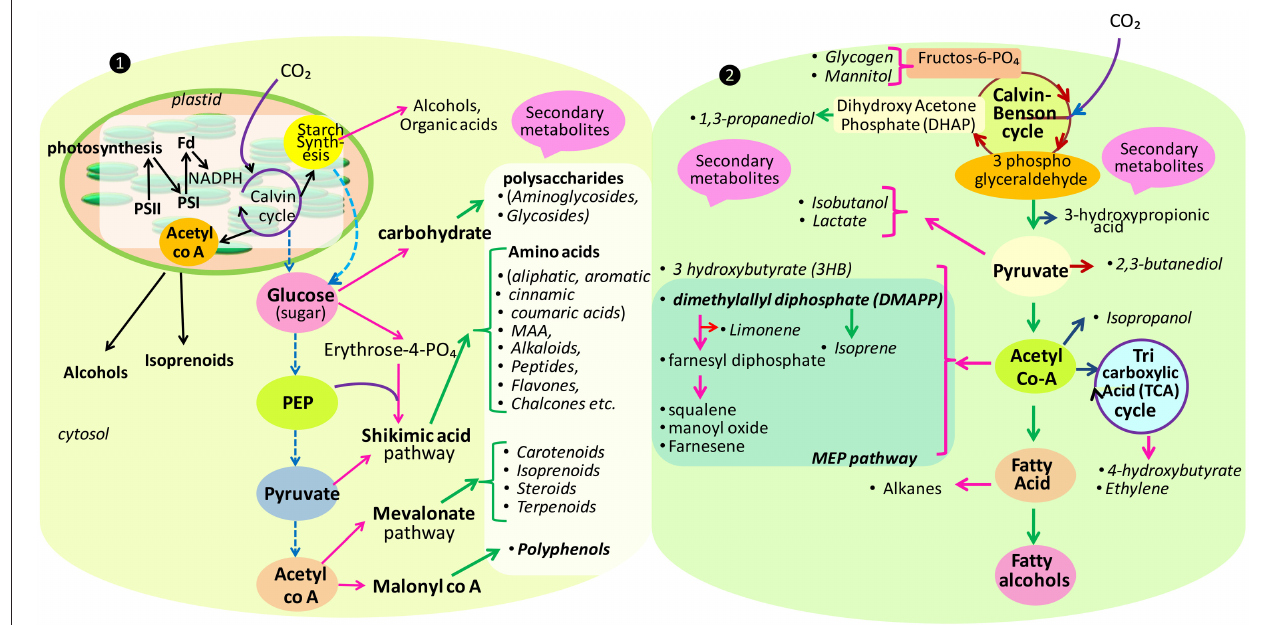
FIGURE 1 | Main pathways for the biosynthesis of some secondary as well-primary (carbohydrate, starch, alcohol, etc.) metabolites in eukaryote ( ¶ ) and prokaryote ( · ) (modified after Burja et al., 2001; Oliver et al., 2016).